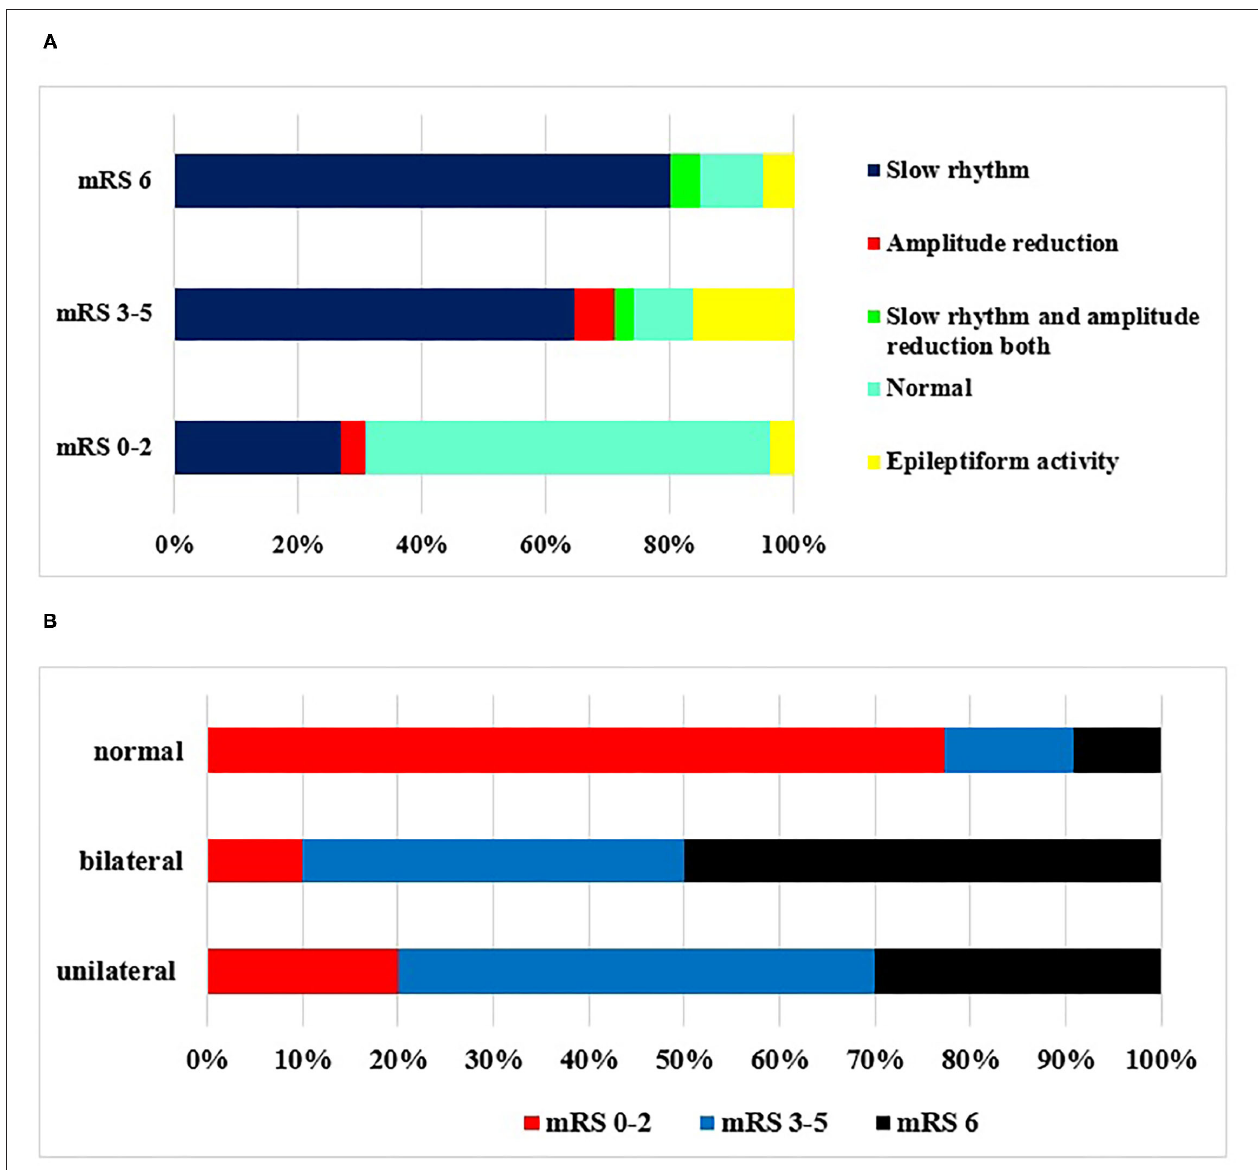
FIGURE 4 | (A,B) EEG abnormalities during the examined period and outcome according to mRS at 3 months. Correlation was seen between poor outcome and presence of EEG abnormalities ( p < 0.05). The definitions of EEG alterations are given in details in Methods . (A) Type of abnormality. (B) Unilateral/bilateral EEG